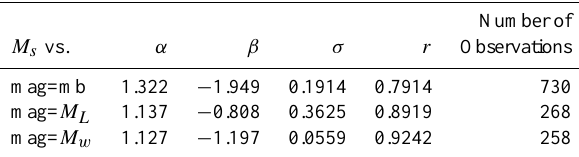
Table 1. Linear relations M s = α · mag+ β ± σ for different magni- tudes used in Chile (see text for details); σ corresponds to the esti- mated error and r the correlation